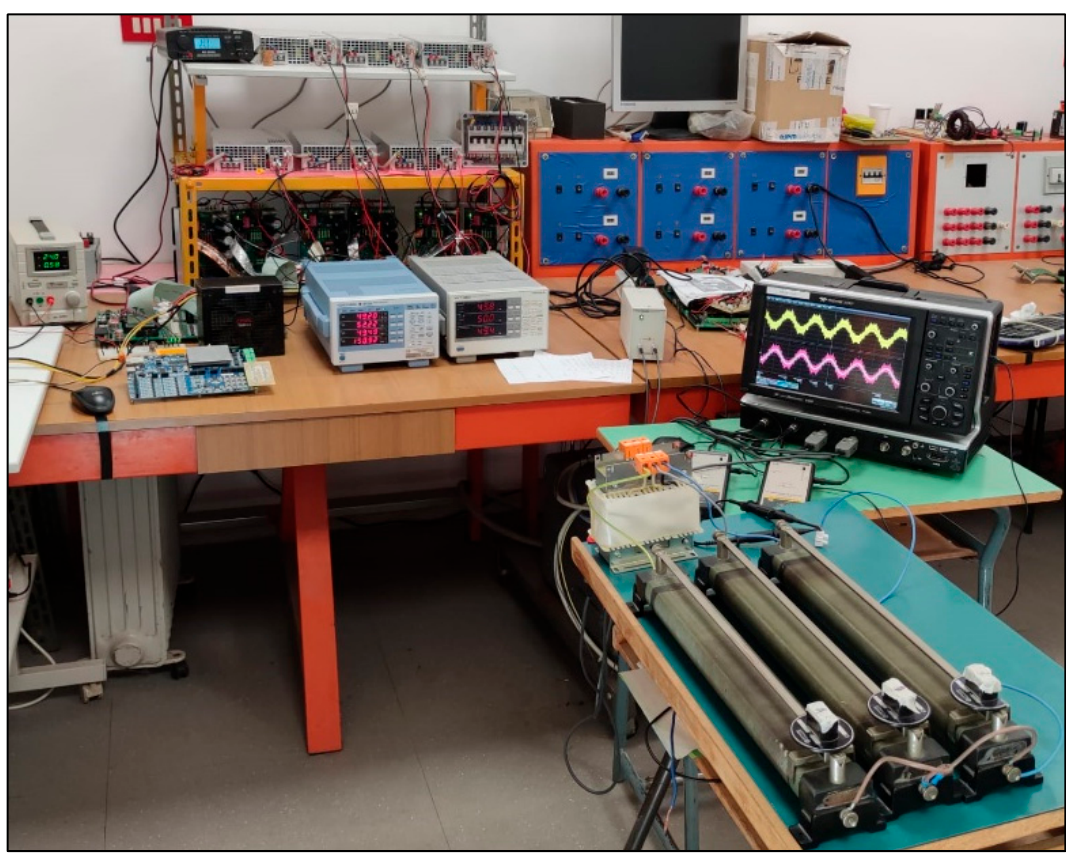
Figure 11. Test bench.